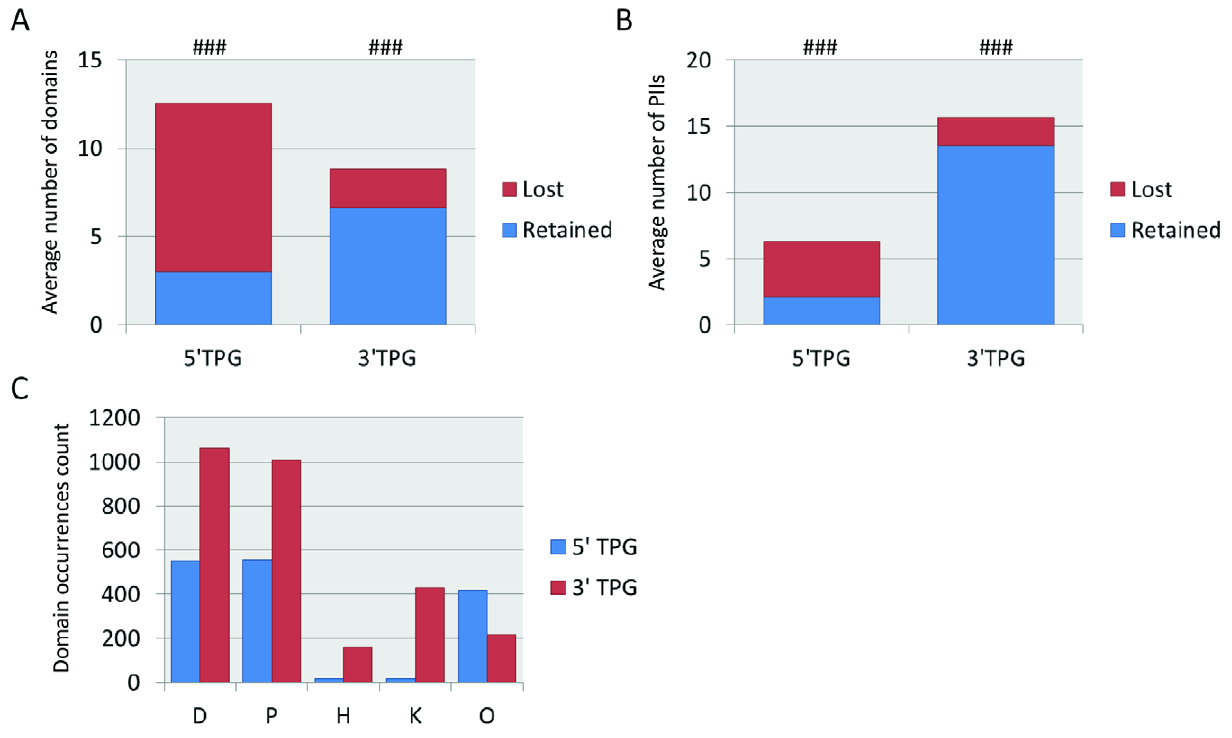
Figure 4. Domains (panel A) and protein interaction interfaces (panel B), retained and lost by fused TPG parts. ### : P , 0.0001, Wilcoxon signed rank test for difference between retained and lost elements in a TPG. C: Total counts for different types of domains retained by